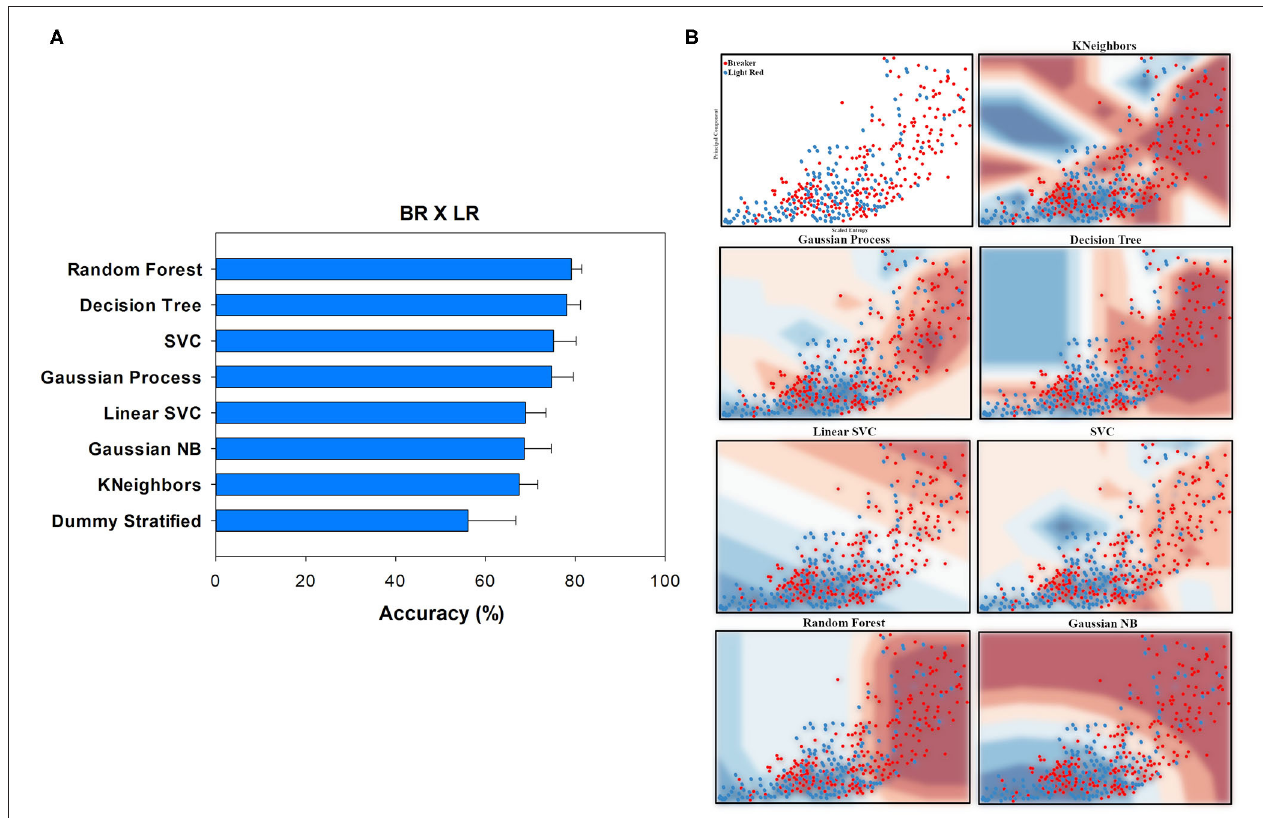
FIGURE 5 | Accuracy (%) and standard deviation (A) of the Machine Learning models used to classify Breaker (BR) and Light Red (LR) classes. Scatter plots (B) showing a sample space plan used in ML training for the BR × LR distribution. Red dots: BR; blue dots: LR. The regions are the demarcations made by ML to indicate levels of certainty of classification. The more reddish it is, the more certain it belongs to the BR group. The more bluish it is, the more certain it belongs to the LR group. The subtitle of each graph indicates the method used. On the y -axis is the data from PCA1. On the x -axis is the distribution of the Scaled Entropy.